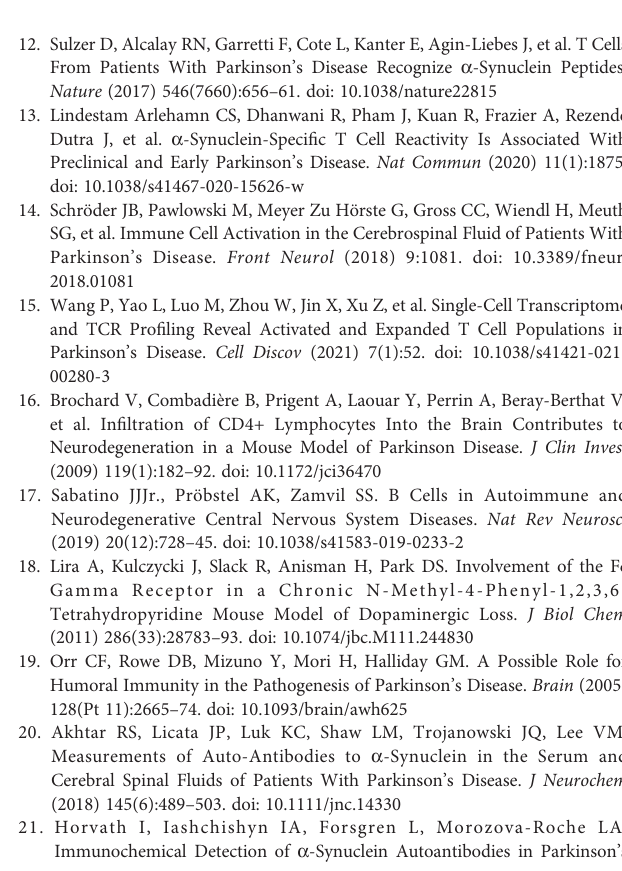
Supplementary Figure 1 | Heatmap showing the percentage of cells in each cluster annotated by three puri fi ed bulk RNA-seq datasets. Supplementary Figure 2 | Volcano plot showing differentially expressed genes (DEGs) between unswitched memory B cells USM1 and USM2 (A) , as well as betweenswitched memoryBcellsSM1andSM2 (B) .Thex-axis representsthefold change between groups, and the y-axis represents P values. Supplementary Table 1 | Summary of single-cell RNA and BCR sequencing data. Supplementary Table 2 | Differentially expressed genes and functionally enriched GO terms and KEGG pathways between PD patients and healthy controls in each B cell